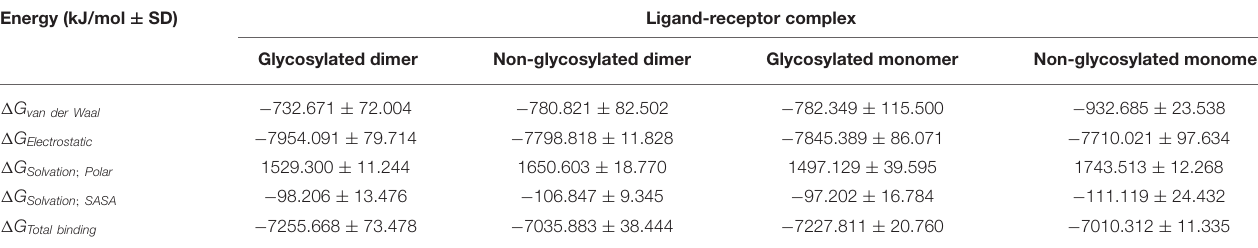
TABLE 4 | Free binding energies ( 1 G Total binding ) and individual energy terms regarding the designed multitope vaccine at h TLR-4 target protein binding site. Energy (kJ/mol ± SD) Ligand-receptor complex Glycosylated dimer Non-glycosylated dimer Glycosylated monomer Non-glycosylated